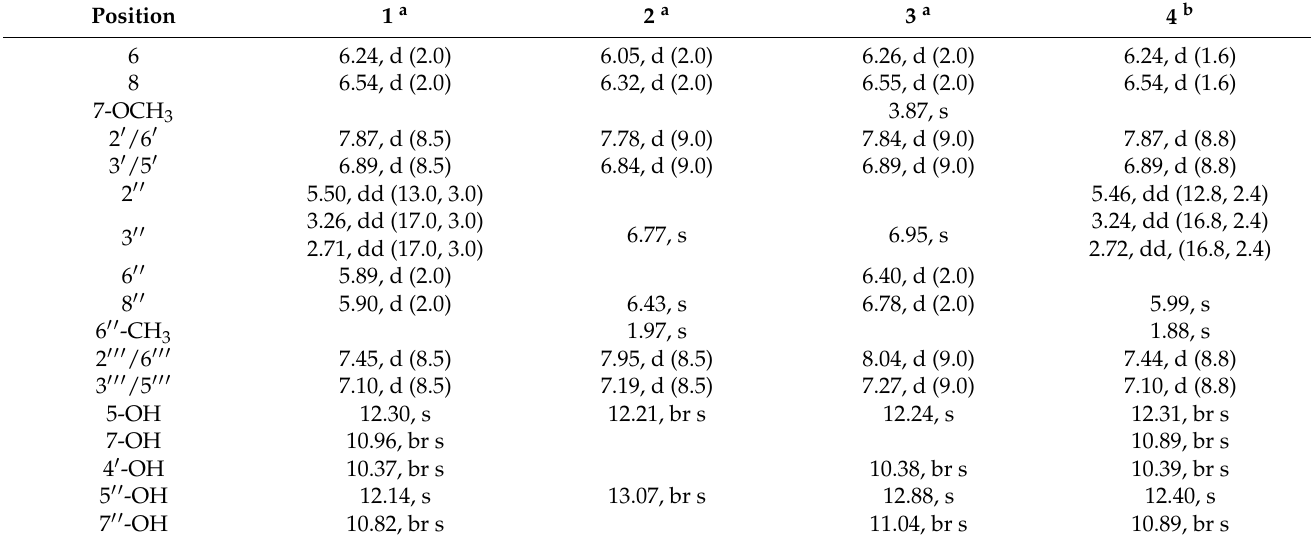
Table 1. 1 H NMR spectral data for compounds 1 – 4 in DMSO- d 6 ( δ in ppm, and J in Hz).